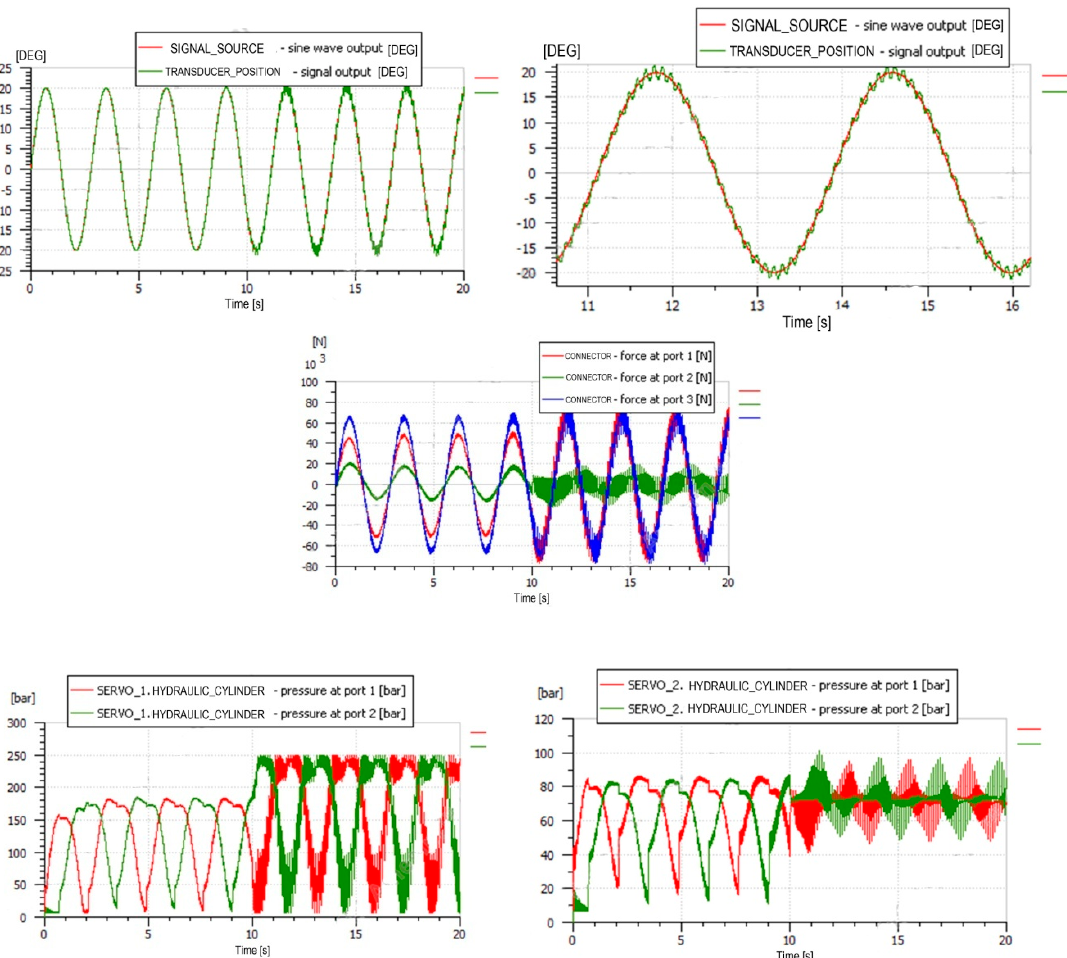
Figure 7. Failure of one servo at reduced flight speed.